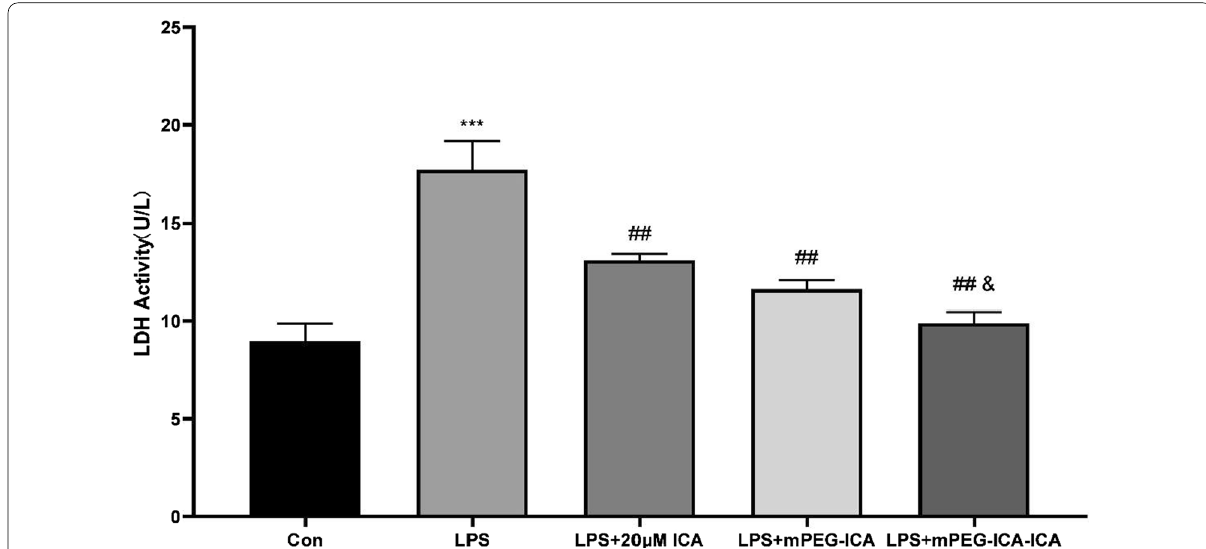
Fig. 7 The effect of ICA nanoparticles on the LDH level induced by LPS in H9c2 cells. Data are the mean versus LPS treatment group; *& P < 0.05 versus LPS